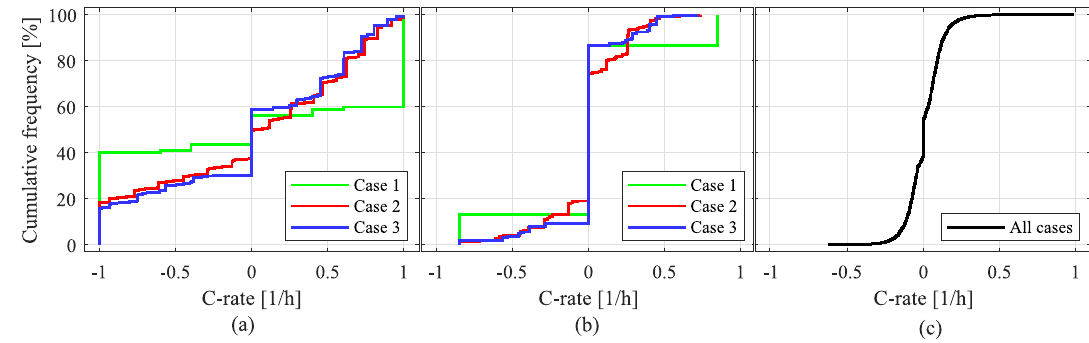
Figure 6. Cumulative probability distributions of C-rate for: ( a ) The intraday market (IDM); ( b ) the day-ahead market (DAM); and ( c ) the